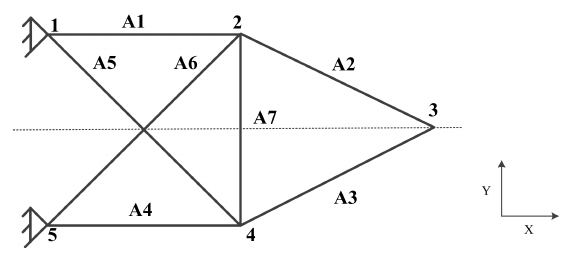
Figure 1. Seven-bar truss